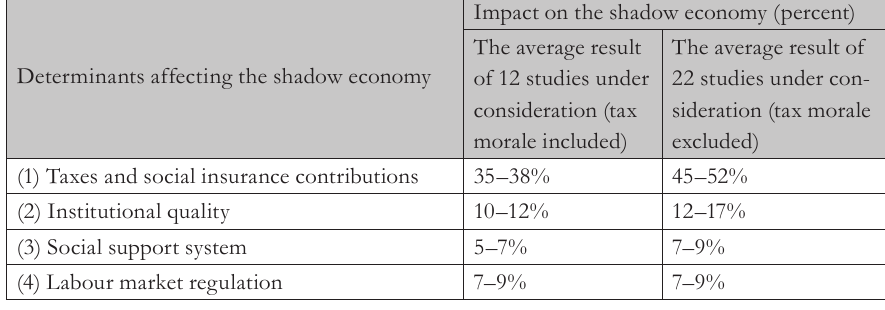
Tab. 2 – Determinants of the shadow economy. Source: Schneider